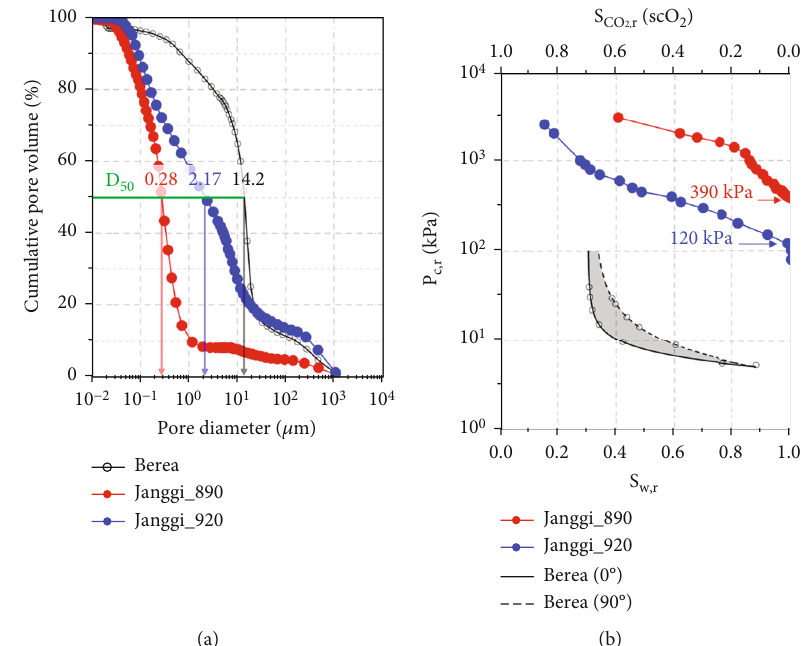
Figure 7: (a) Cumulative pore volume curve derived from MIP result and (b) capillary pressure curve when fl ooding scCO sandstone and Janggi Basin